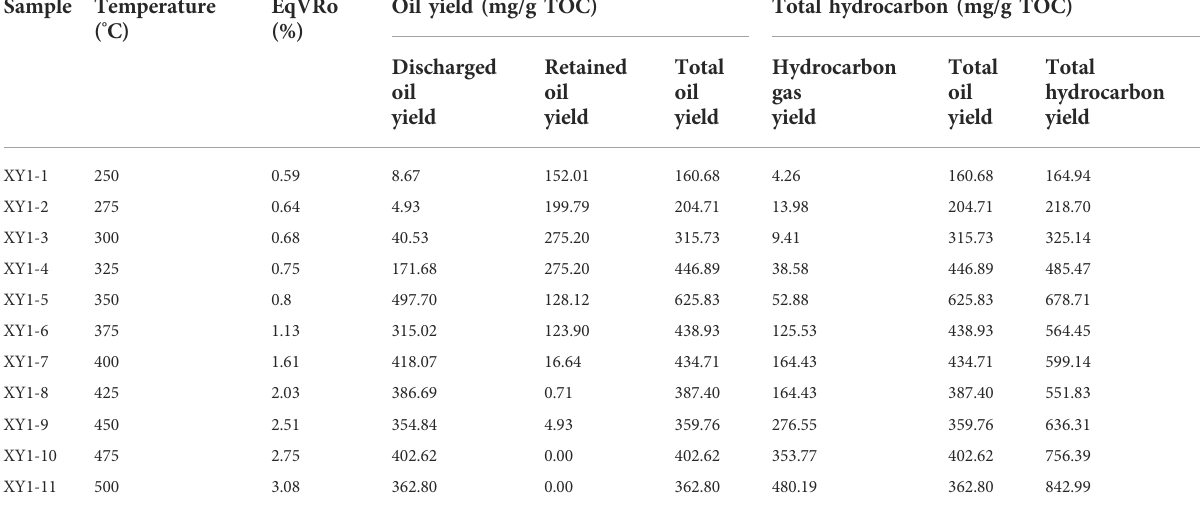
TABLE 5 Retained and discharged oil yields of model 2.